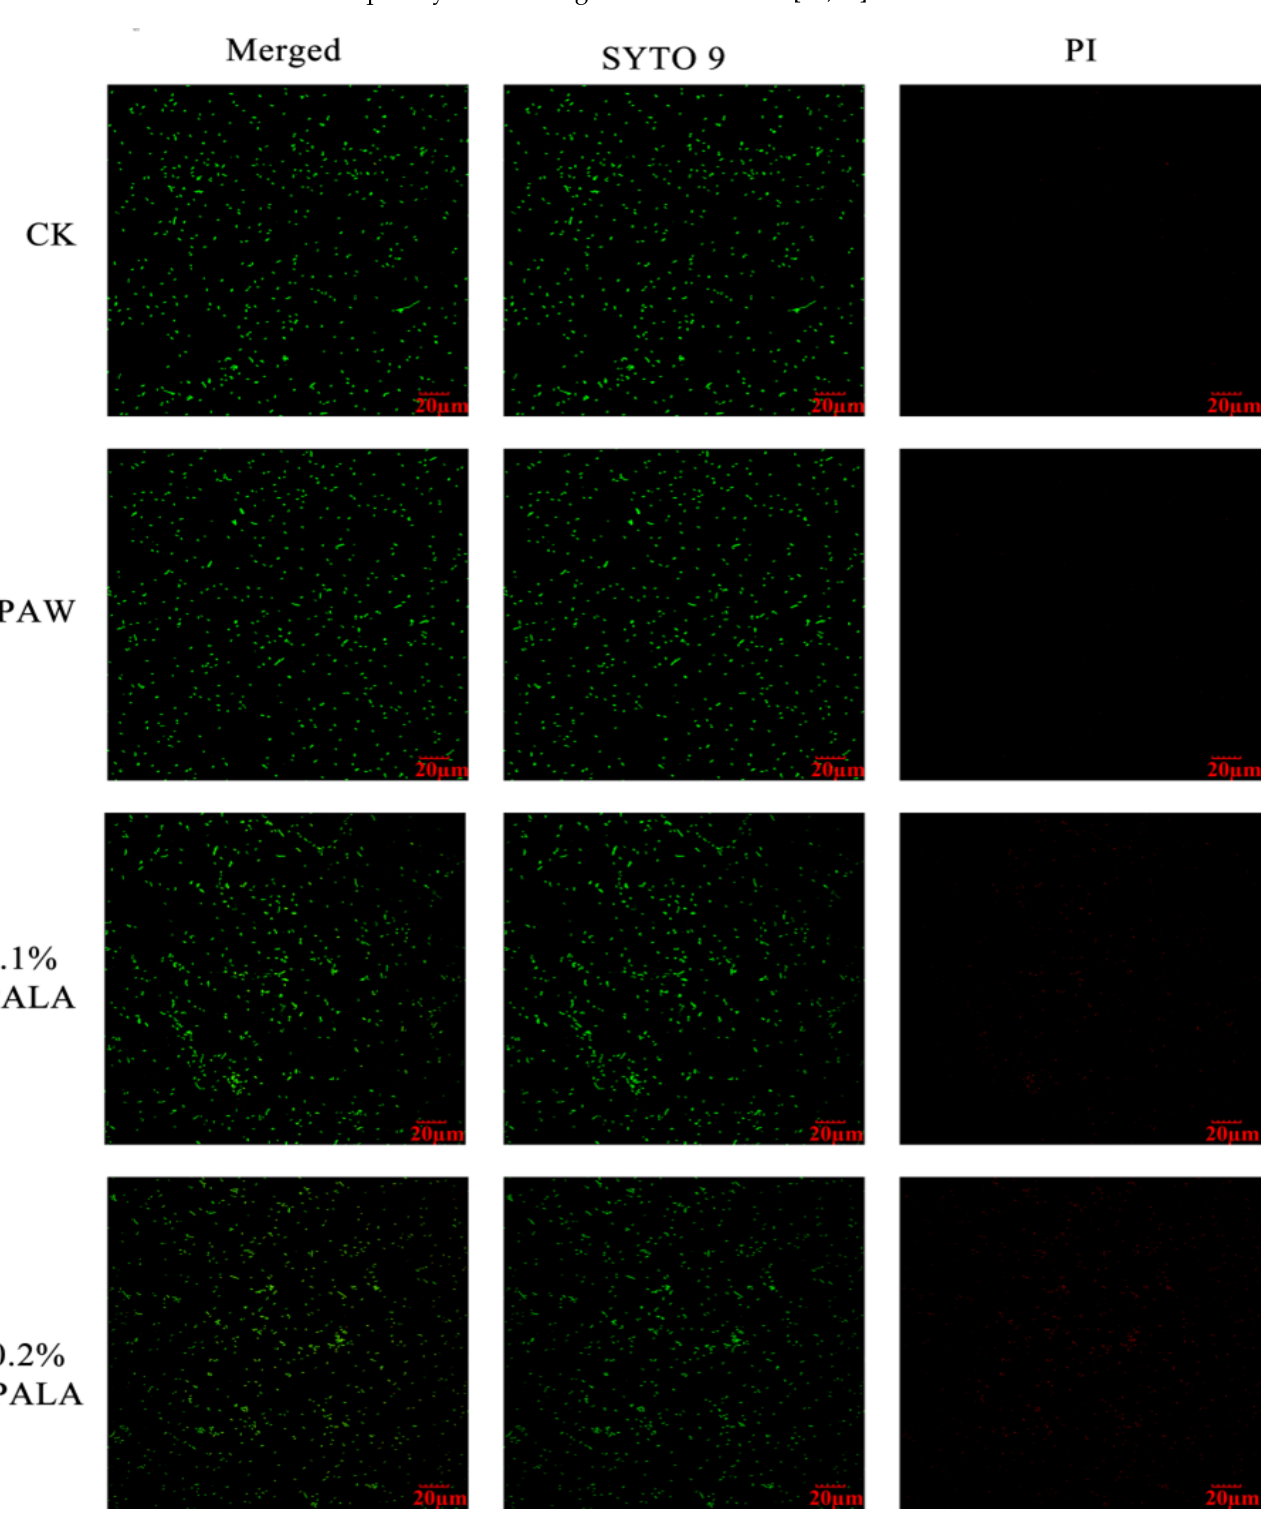
Figure 3. LSCM images of bacteria after DIW, PAW, PALA (0.10%) and PALA (0.20%) treatment. The scan bar is 20 μm. Each row shows Merged, SYTO-9 (green fluorescing dye) and PI (red fluorescing dye) stained samplec DIW: deionized water; LA: lactic acid; PAW: plasma-activated water; PALA: plasma-activated lactic acid.